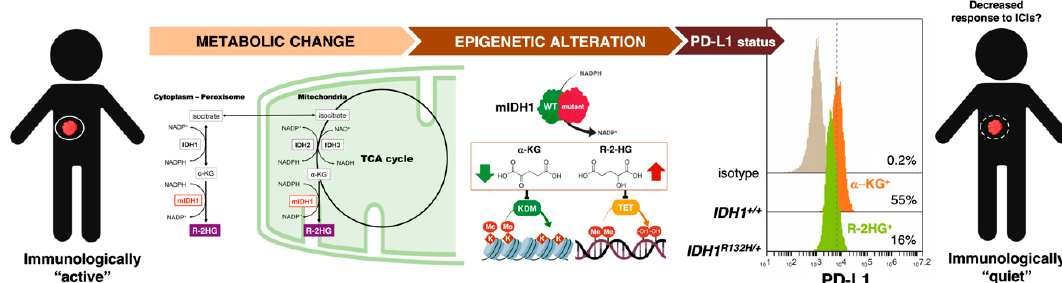
Figure 3. Oncometabolites can su ffi ce to epigenetically regulate programmed death ligand 1 (PD-L1) expression in cancer cells. Beyond the well-recognized genetically-directed adaptations in nutrient acquisition (e.g., uptake of glucose and amino acids) and reprogramming of intracellular metabolic pathways (e.g., use of glycolysis / tricarboxylic acid cycle (TCA) intermediates for accelerated biosynthesis and NADPH production, increased demand for nitrogen, etc.), select metabolic activities and metabolites can directly a ff ect the behavior and function not only of non-tumor cells residing in the TME, but also of cancer cells themselves via modification of the epigenetic landscape. Oncometabolites such as R-2-hydroxyglutarate (R-2HG), succinate, and fumarate are prototypes of such a class of cancer-promoting metabolites sharing a common causal mechanism in malignant transformation—namely the promotion of histone and DNA hypermethylation. Such rewiring of the epigenome causally drives the accumulation of undi ff erentiated cells with tumor-initiating capacity that might be accompanied by changes in the expression of immune checkpoints such as PD-L1. The ability of oncometabolites to drive immune quiescence in the TME while promoting DNA methylation in the regulation of immune checkpoint genes ( PD-L1 ) might be of significance for the potential therapeutic application of immunotherapies in certain cancer subtypes (e.g., low-grade gliomas). However, it is also possible that the presence of abnormal proteins in isocitrate dehydrogenase 1 (IDH1)-mutated cancer cells may boost immune responses in other cancers. The figure shows that the introduction of the 2HG-producing mutant IDH1 enzyme in an otherwise isogenic background su ffi ces to downregulate the expression of PD-L1 in MCF10A breast epithelial cells, a regulatory e ff ect that can be specifically reverted by R-2HG-inhibiting and hypomethylating drugs